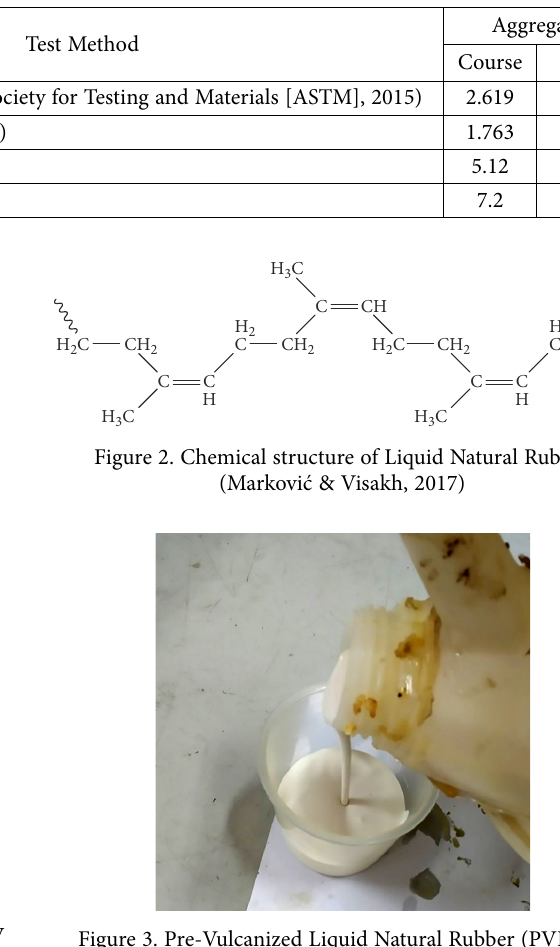
Figure 3. Pre-Vulcanized Liquid Natural Rubber (PVLNR)